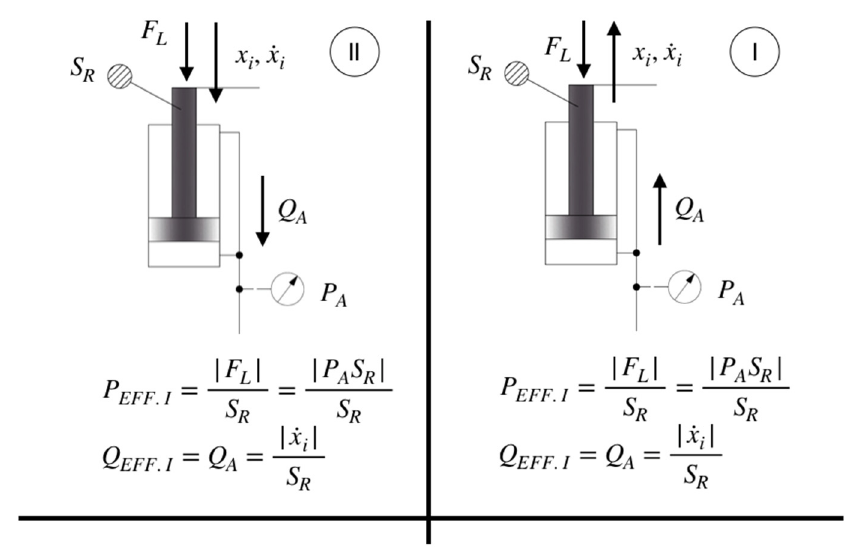
Figure A1. Effective pressure and flow in quadrants I & II for the lift actuator.